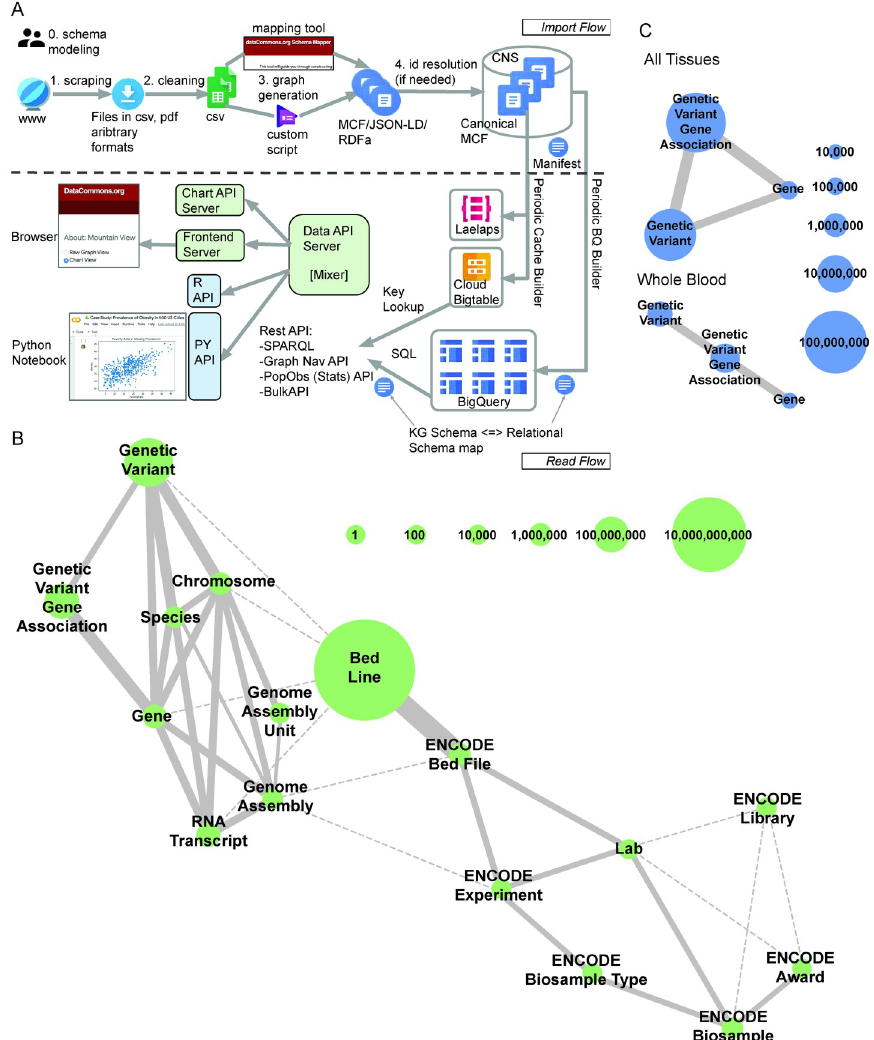
Fig 1. Biomedical Data Commons is a knowledge graph that integrates multiple data types. A: Workflow for cleaning, formatting, ingesting, and accessing data in the Google Biomedical Data Commons knowledge graph. B: Current state of the Google Biomedical Data Commons graph. The size of the node indicates the number of unique entities of that type in the graph. Solid edges depict explicit relationships between two entity types with edge width corresponding to the number of unique links between the entity types. Dashed line edges denote implicit relationships in the graph. C: A depiction of the subgraph of Biomedical Data Commons displaying the Gene, GeneticVariant, and GeneGeneticVariantAssociation nodes and edges in total (top panel) and the subset of which are reported as significantly associated in Whole Blood by GTEx (bottom panel). Node size and edge width correspond to the number of unique entities of that type and relationships between two entity types respectively. This represents how a user can use the Data Commons API to search and retrieve information contained in a subset of the graph in which they are